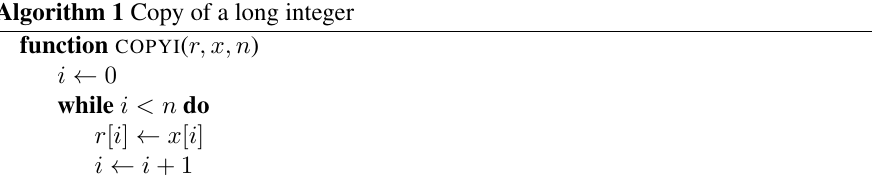
Fig. 2. Some Hoare triple inference